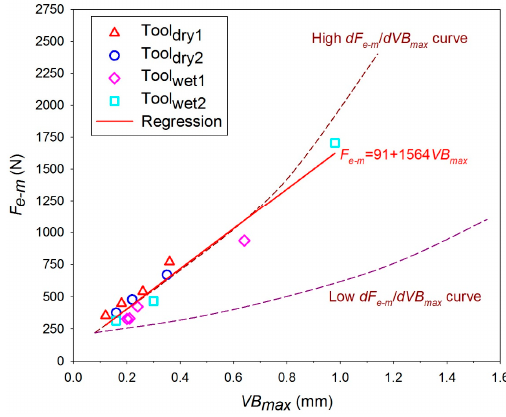
Figure 11. F e-m values versus VB max for experiments conducted using f t = 0.1 mm/rev. The upper-bound (high) and lower-bound (low) d F e-m /d VB max curves for f t = 0.05 mm/rev [12] are also plotted.